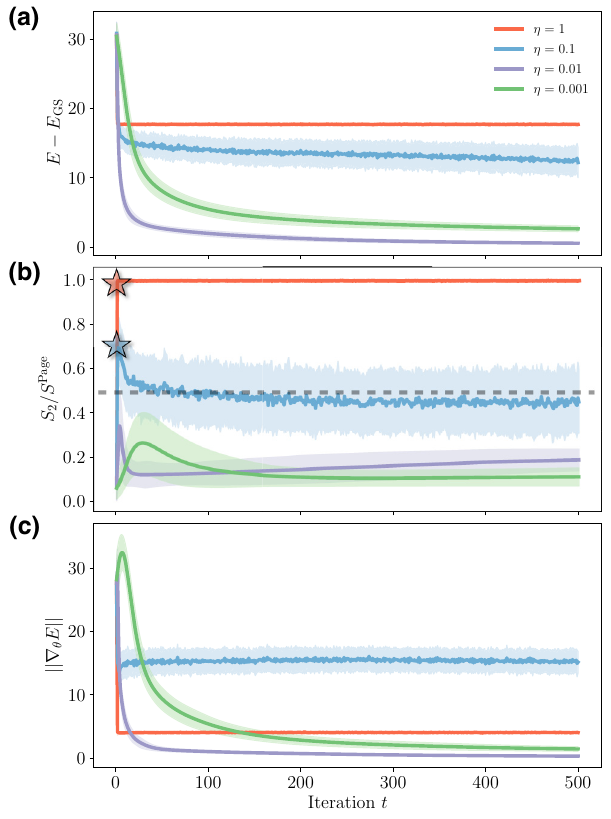
FIG. 5. (a)–(c) The application of the proposed algorithm to the problem of finding the ground state of the Heisenberg model. For large learning rates η = 1 and 0.1 (red and blue lines) the optimization gets into a large entanglement region as is shown in (b), indicated by colored stars, forcing the restart of the optimiza- tion with smaller value of η . For η = 0.01 the algorithm avoids large entanglement region and gets a good approximation for the ground state. Finally, setting even smaller learning rate (green lines) degrades the performance. The normalized second Rényi entropy of the true ground state is S 2 / S Page ( k , N ) ≈ 0.246. (c) Shows the corresponding gradient norm. A small gradient norm equally corresponds to the BP and the good local minima found with η = 0.01 and 0.001. We use a system size of N = 10, sub- system size k = 2, and a random circuit [see Eq. (1)] with circuit depth p = 100 and small qubit rotations ( (cid:11) θ = 0.05) to gener- ate a BP-free initialization. Here we choose α = 0.5 indicated by the gray dashed line, see the last paragraph of Sec. III A for a discussion on the choice of α . Data is averaged over 100 random